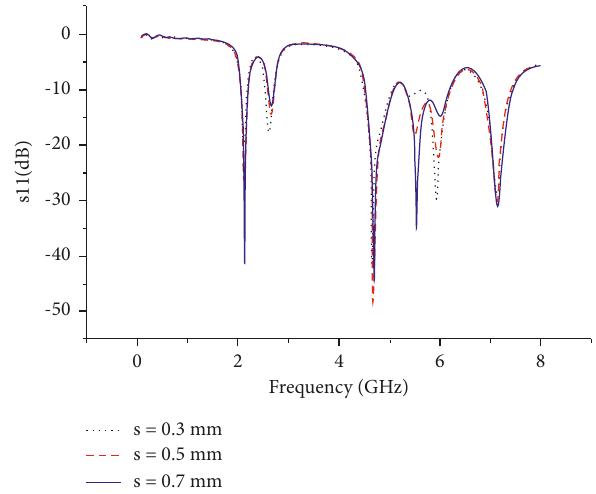
Figure 8: Return loss comparison for various split widths of HCSRR.